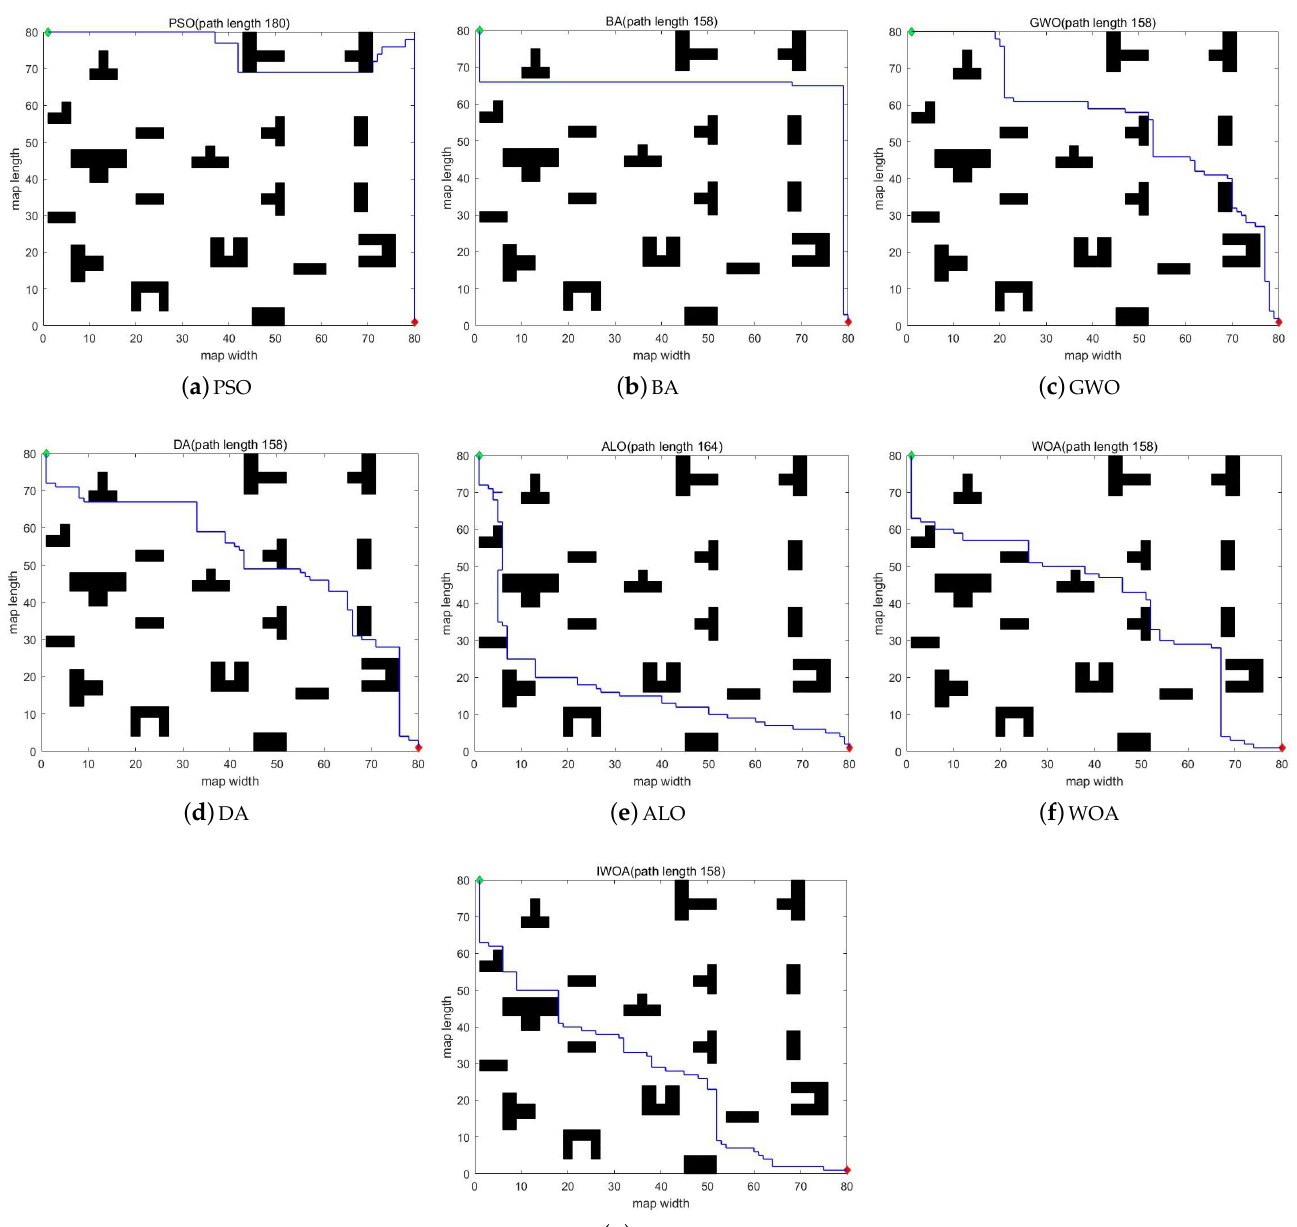
Figure 18. Actual path traces of seven different algorithms on 80 × 80 size